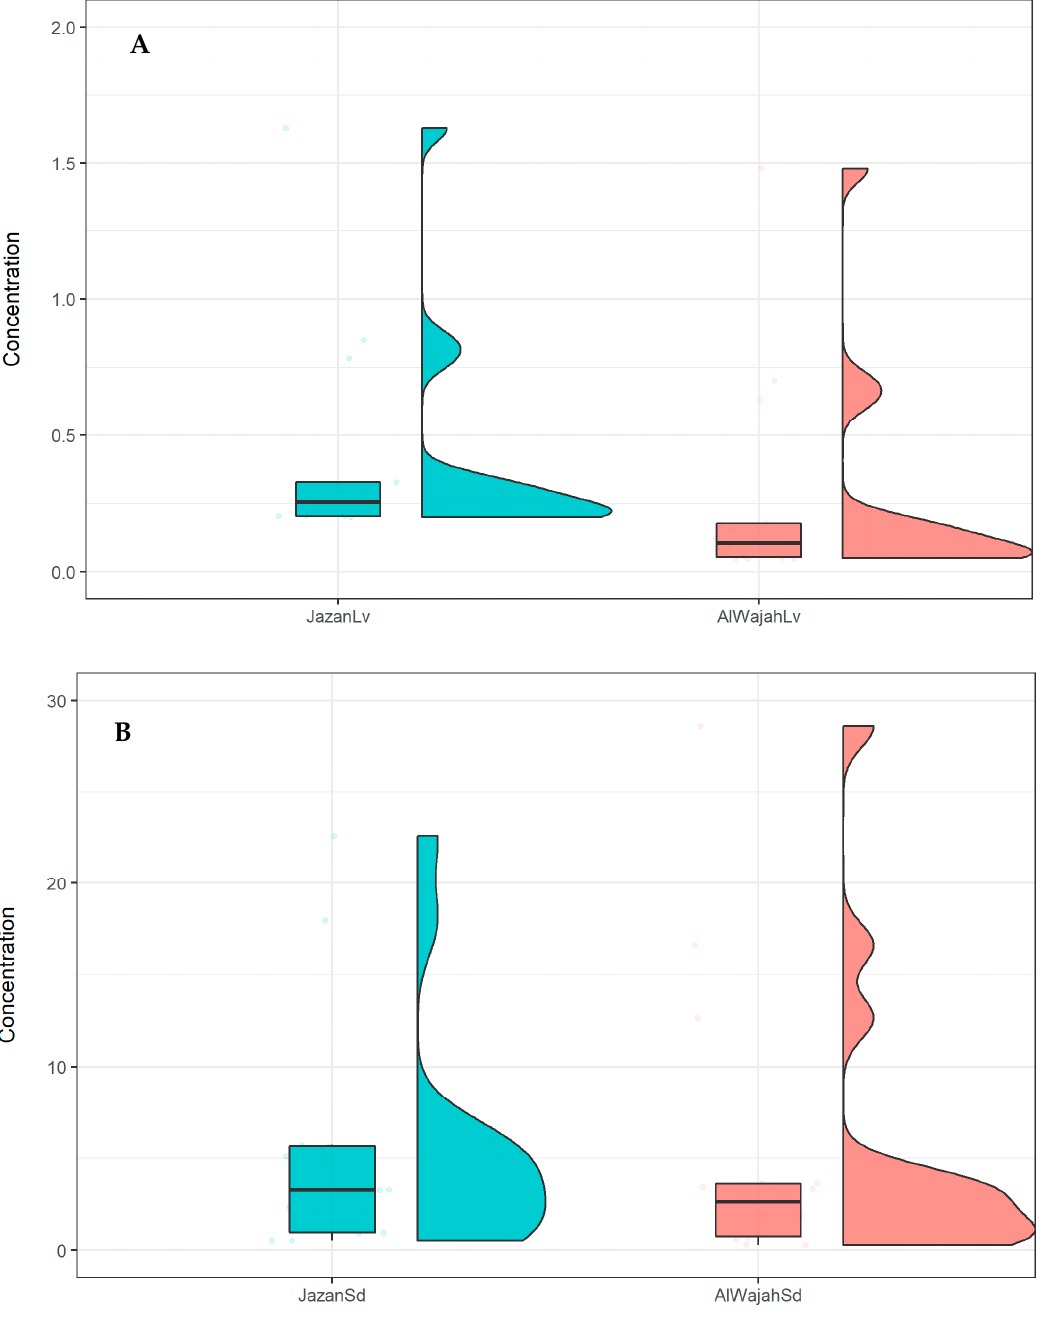
Figure 4. Box and violin plot for distribution of REE in mangrove sediment ( A ) and A. marina ( B ). The boxplot for each mangrove displayed the distribution based on the minimum, median, and maximum value, while the violin plot depicts the distribution and density of variables for each